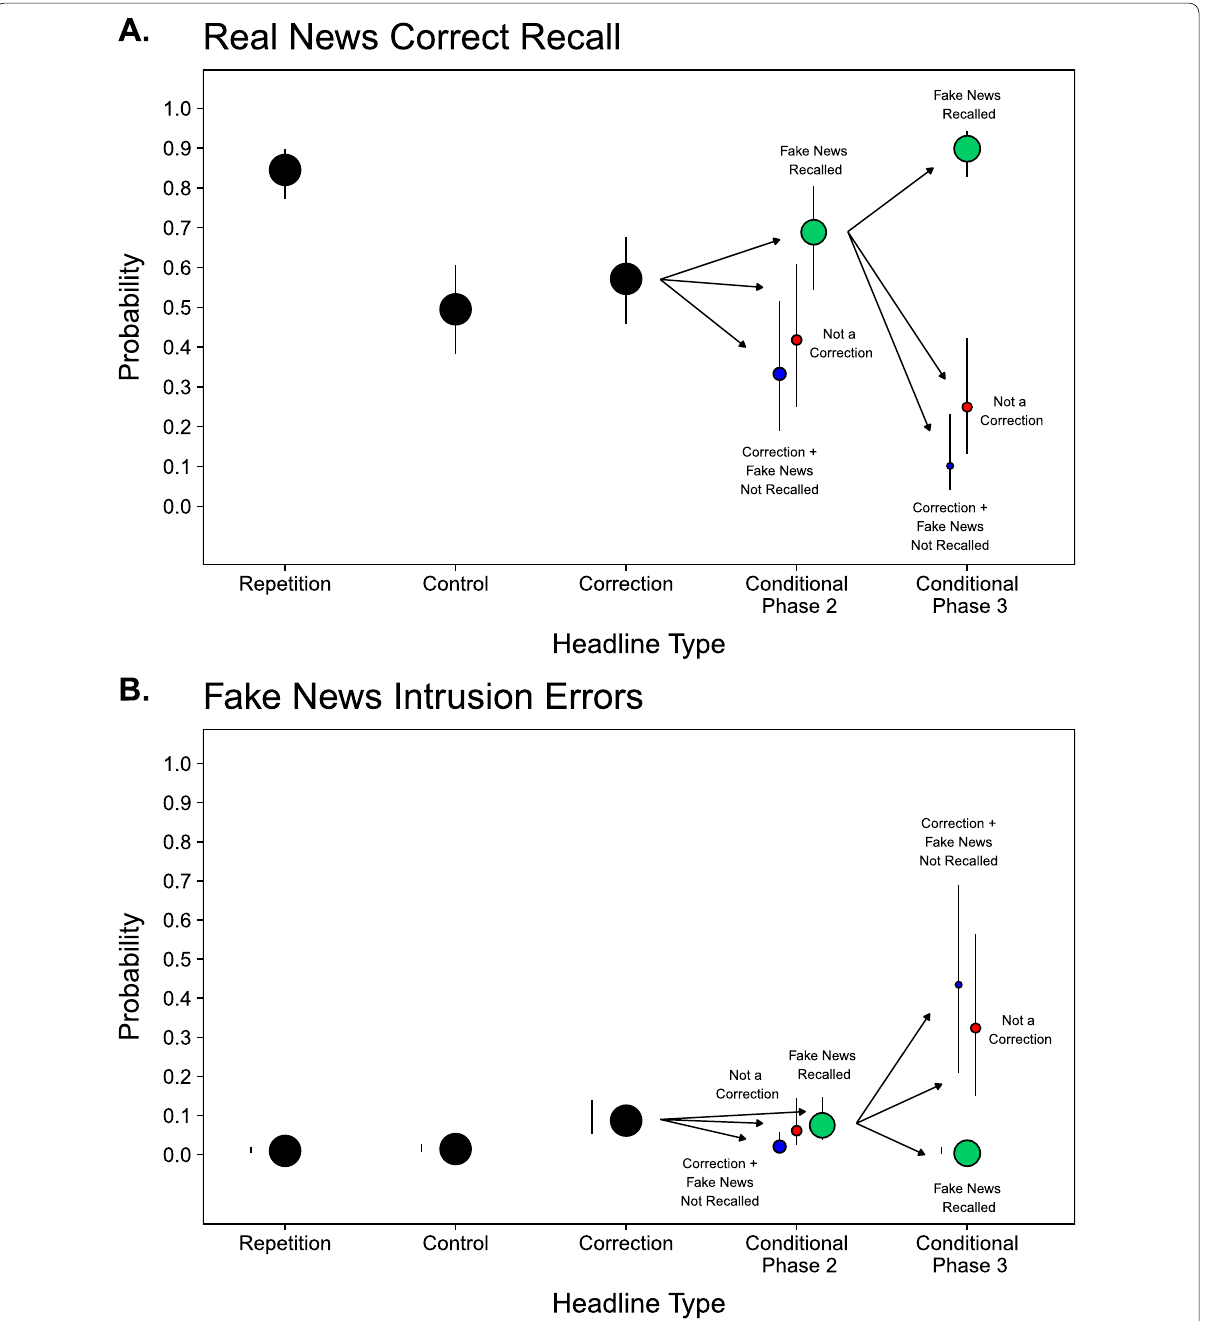
Fig. 2 Recall of Real News and Intrusions of Fake News: Experiment 1. Probabilities of real news correct recall (Panel A) and fake news intrusion errors (Panel B) as a function of Headline Type in Experiment 1. Black points represent probabilities for all observations. Colored points represent probabilities conditioned on correction classification types in Phases 2 and 3. The cells represent corrections that were classified as such and for which fake news was recalled (green points), corrections that were classified as such and for which fake news was not recalled (blue points), and corrections that were not classified as such (red points). The size of each point indicates the relative proportion of observations in each cell. Error bars are 95% confidence intervals and are displayed adjacent to the points when the intervals lengths are shorter than point